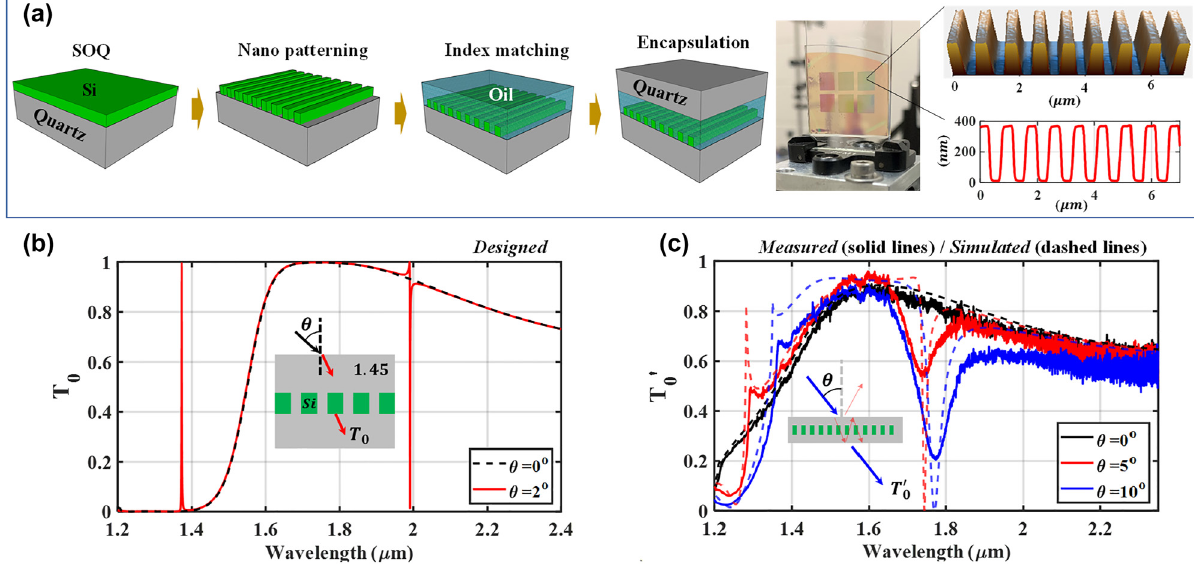
Figure 6: Experimental verification of the existence of singular states in simple resonant lattices. (a) Fabrication procedure of a Si membrane that includes four steps: preparing an SOQ wafer (crystalline Si on quartz), nanopatterning, refractive-index matching, and encapsulating. A photographic image shows the membrane cells embedded in two quartz substrates. The microscopic image and grating profiles are characterized with AFM = 3.48) membrane in quartz ( n = 1.45) to expose a singular state where the grating parameter set ( Λ = 0.835 measurements. (b) Design of c-Si ( n Si Qz μ m, F = 0.522 and H = 0.329 μ m) is optimized by our PSO algorithm. In the T spectra, the singular state and EIT-like resonance locate at λ = 1.991 and 0 spectra (solid lines) for different incidence angles of 𝜃 = 0 ◦ , 5 ◦ and 10 ◦ 1.373 μ m under oblique incidence ( 𝜃 = 2 ◦ ) in TE polarization. (c) Measured T ′ 0 where the parameter set of the fabricated device is ( Λ = 0.835 μ m, F = 0.396 and H = 0.33 μ m). For comparison, the simulated external T ′ spectra 0 (dashed lines) are depicted for the same grating